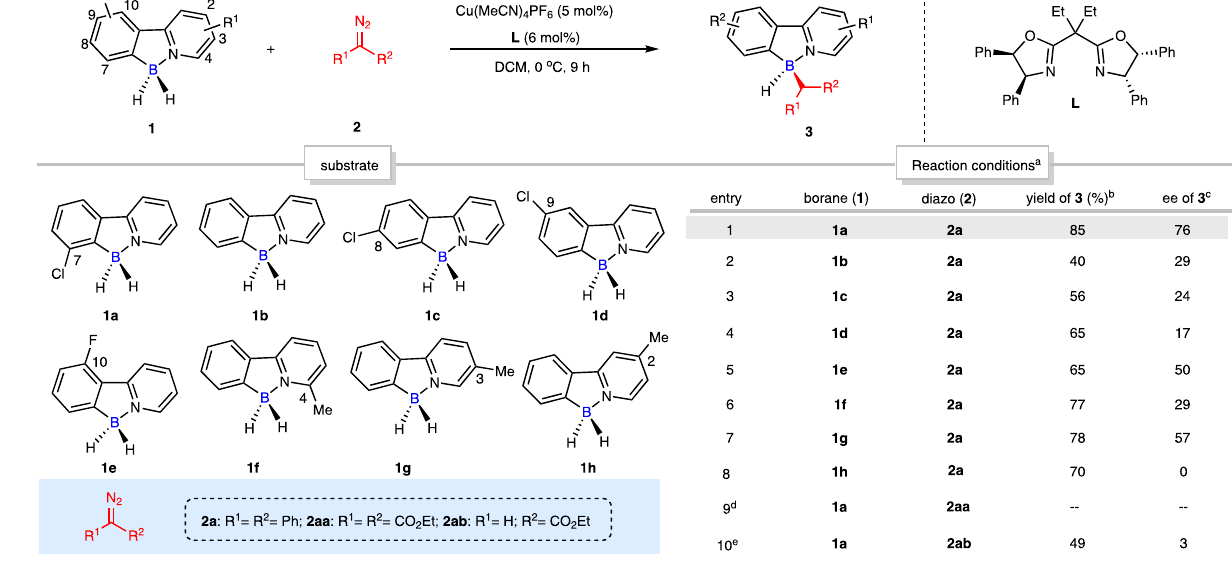
Fig. 2 Initial substrate assessment of desymmetric B – H bond insertion reaction. Conditions: a 2-arylpyridine-borane ( 1 ) (0.1 mmol, 1.0 equiv), diazo compound ( 2 ) (0.1 mmol, 1.0 equiv), Cu(MeCN) 4 PF 6 (5 mol%), ligand L (6 mol%), solvent (1 mL) at 0 °C for 9 h. b Isolated yield. c Determined by chiral HPLC. d Diazo compound 2aa instead of 2a . e Diazo compound 2ab instead of 2a